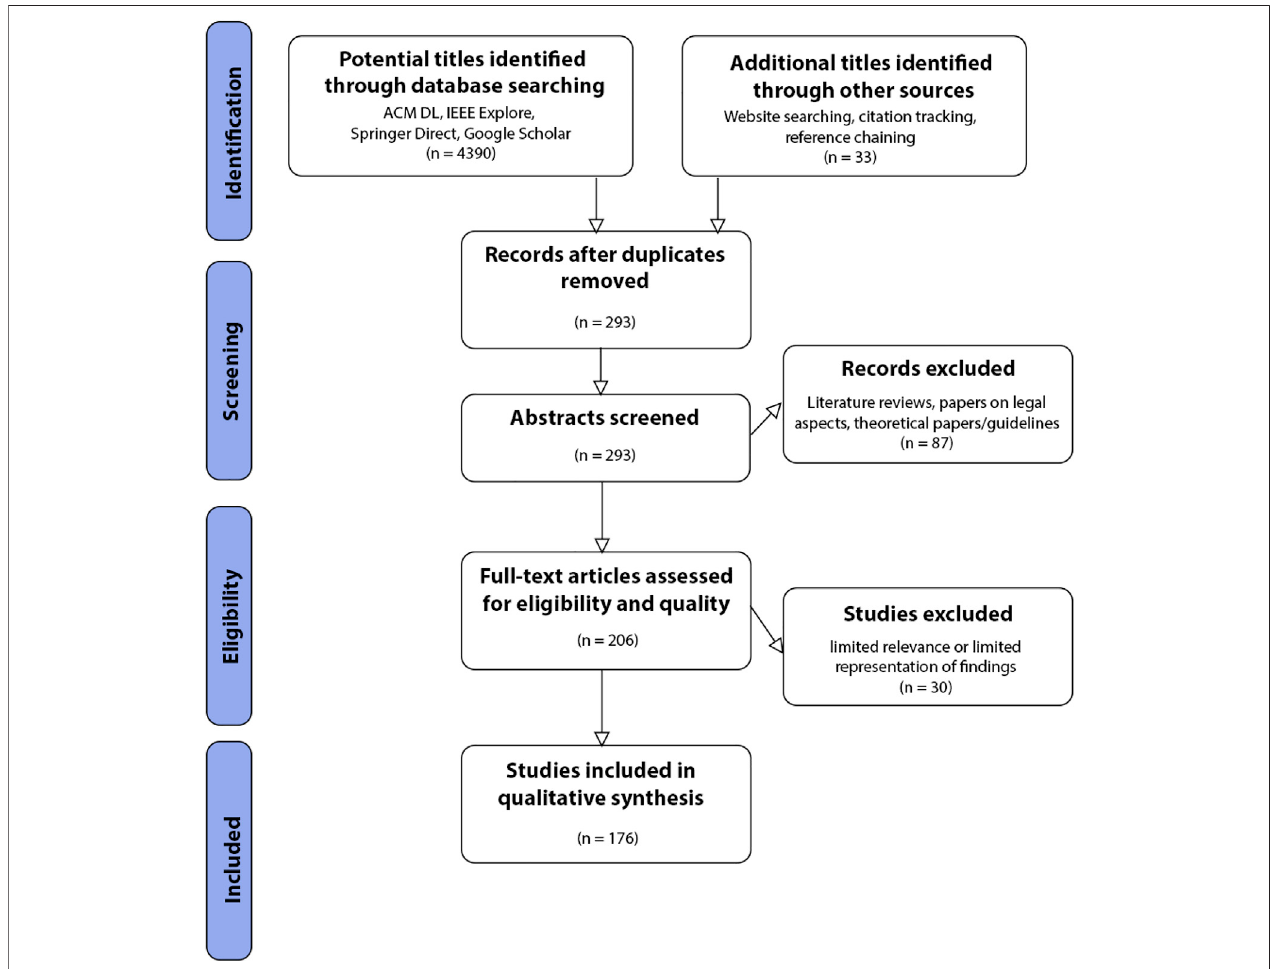
FIGURE 2 | PRISMA fl ow diagram depicting the paper selection